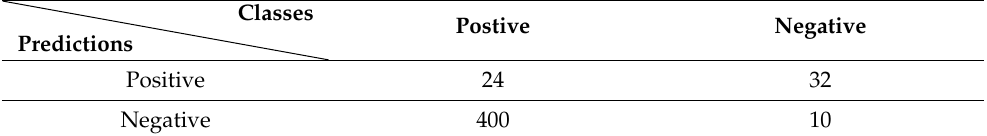
Table 5. Confusion matrix